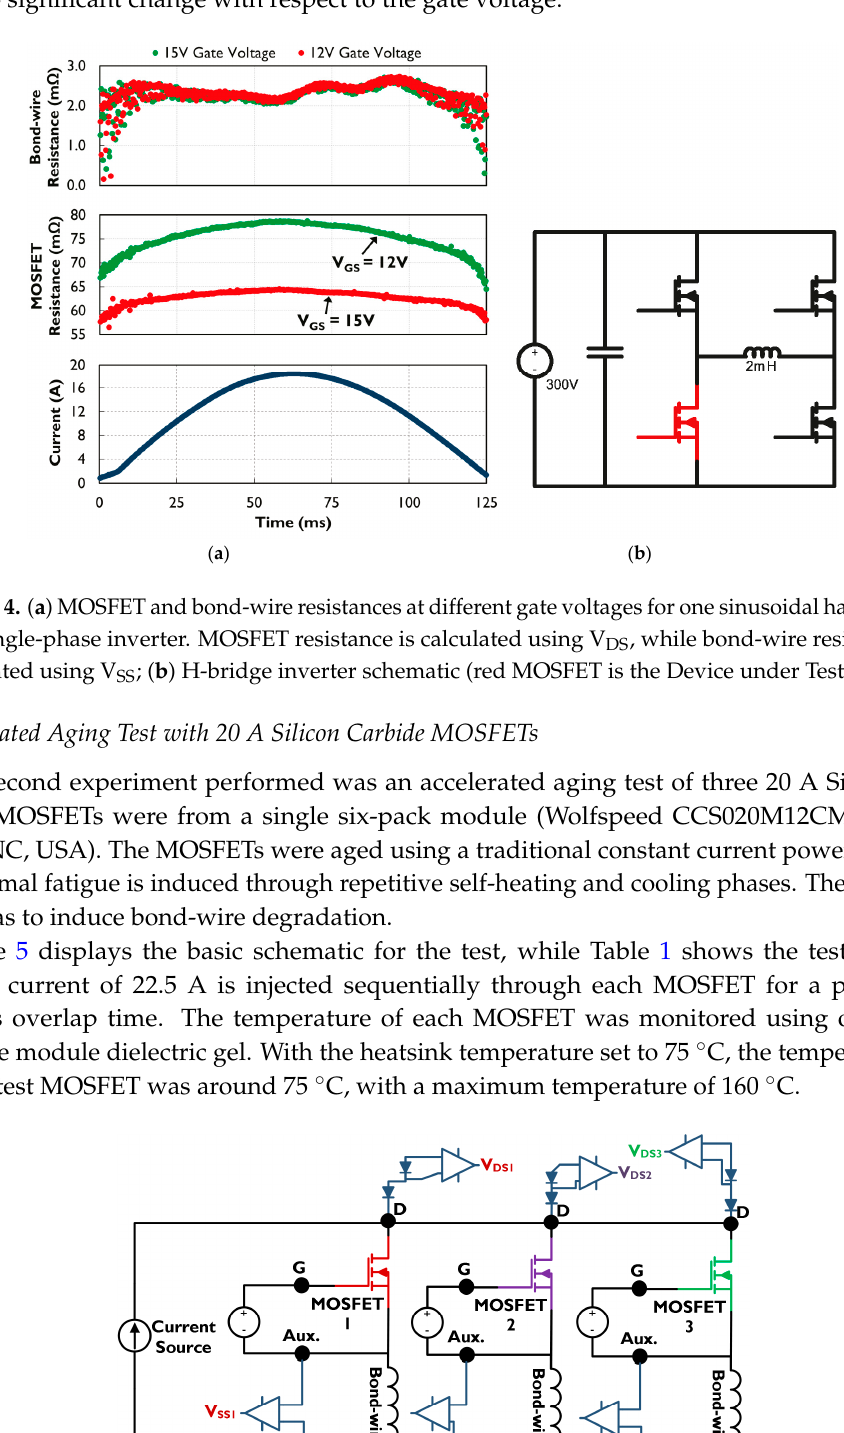
Figure 5. Setup for Power Cycling Test of three SiC MOSFETs.